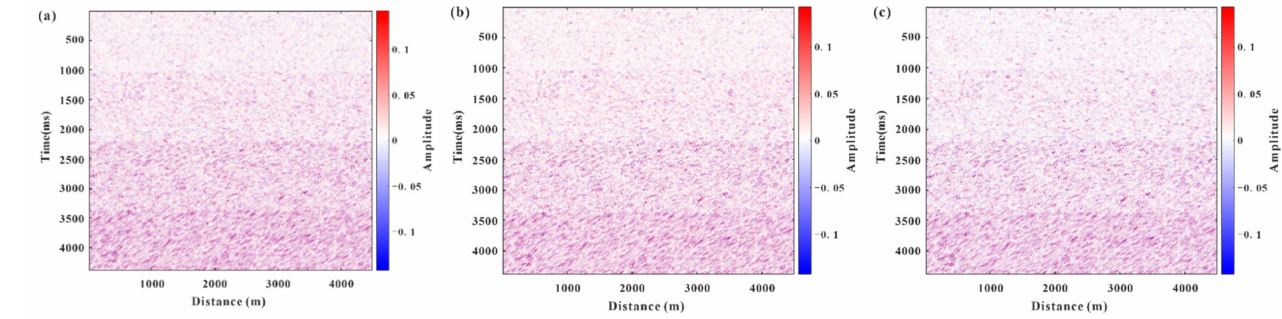
Figure 4. Synthetic seismic data from different center angles: ( a ) 7 ◦ , ( b ) 18 ◦ , ( c ) 26 ◦